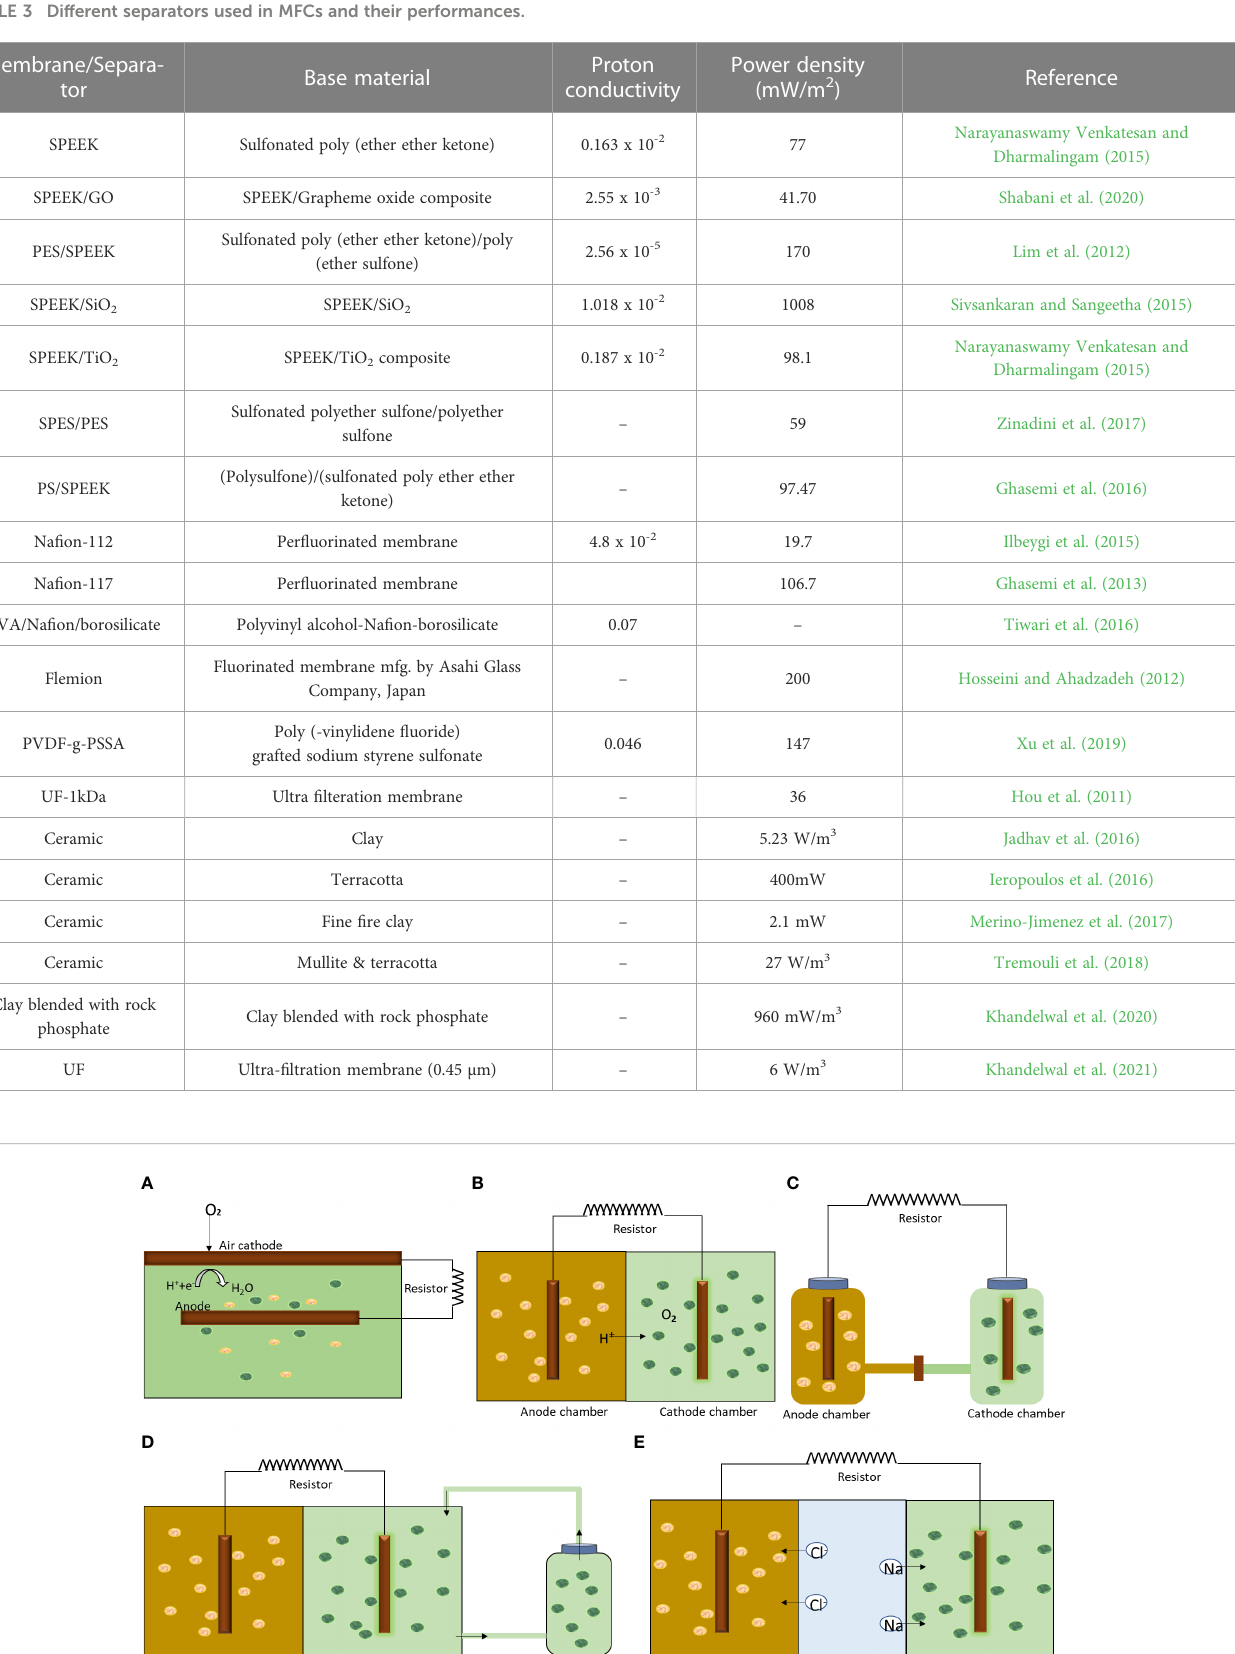
TABLE 3 Different separators used in MFCs and their performances.